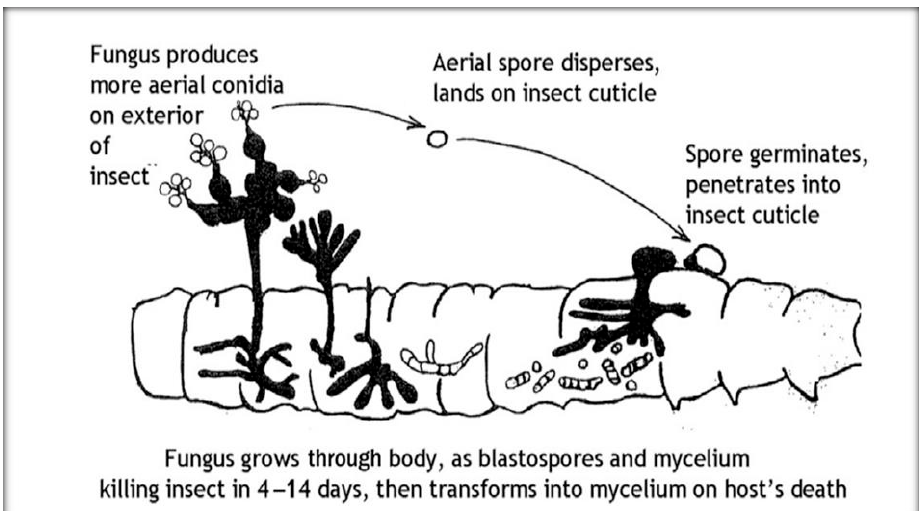
Figure 6. Schematic of the life cycle of entomopathogenic fungi [66].